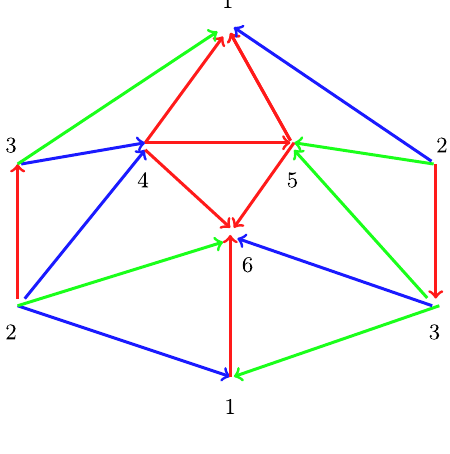
Figure 5: An edge - colored